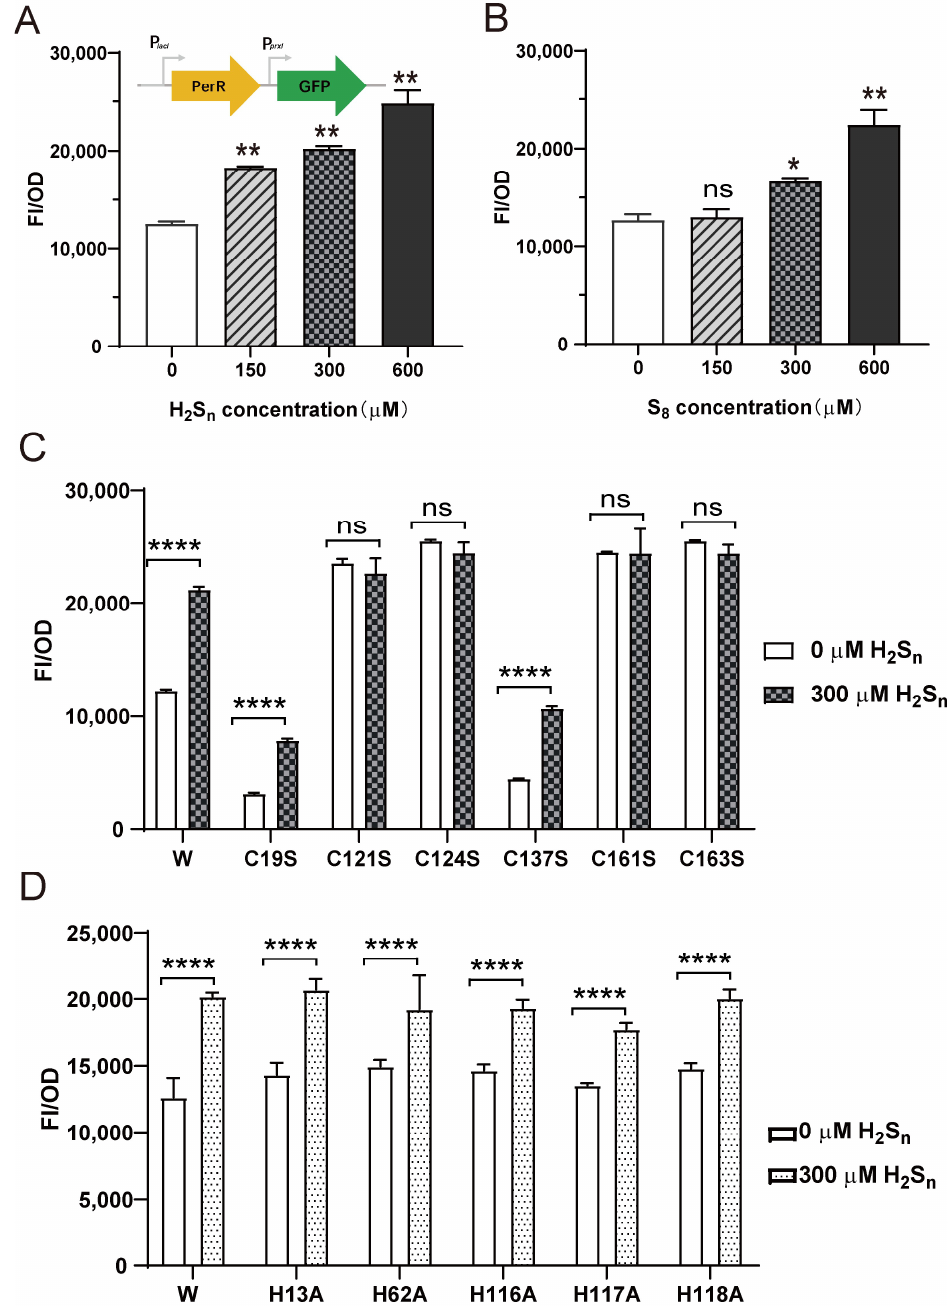
Figure 3. The effect of H 2 S n and S 8 on the PerR-repressed reporter. ( A ) Schematic representation of the test plasmid (pBBR- perR -P prxI - egfp ). The expression of egfp was initiated by the prxI promoter (P prxI ), and the interaction between PerR and P prxI , which was associated with the inducers that affected GFP fluorescence. H 2 S n ( A ) and S 8 ( B ) induction increased the intensity of GFP fluorescence in E. coli BL21 (pBBR- perR -P prxI - egfp ). ( C ) The mutation of Cys affected the function of PerR in E. coli BL21 (pBBR- perR -P prxI - egfp ). C19S, C121S, C124S, C137S, C161S, and C163S represented single mutations of Cys to Ser in PerR. ( D ) The mutation of His did not affect the function of PerR in E. coli BL21 (pBBR- perR -P prxI - egfp ). H13A, H62A, H116A, H117A and H118A represented single mutations of His to Ala in PerR. FI/OD represents the fluorescence intensity of per OD cells. All data are averages from three samples with standard deviations (error bars). The experiment was repeated at least three times. *, p < 0.1; **, p < 0.01; ****, p < 0.0001; ns, not significant (paired t test).